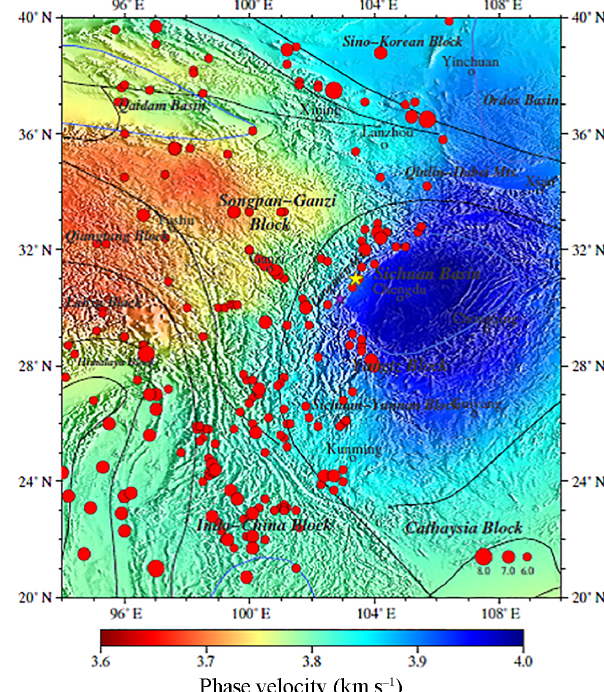
Figure 4. Average phase velocity of the western Yangtze craton (Xie et al., 2013) from 10 to 35mHz. The black lines in the figure show structure lines. The blue lines show boundaries of sedimentary basins. The red dots show seismic events in this region from 1975 to 2015, and the size of a dot demonstrates the size in magnitude from M s 6.0 to M s 8.0. The yellow and purple stars demonstrate the Wenchuan and Lushan earthquakes respectively. These are the same as Figs. 4, 6, and